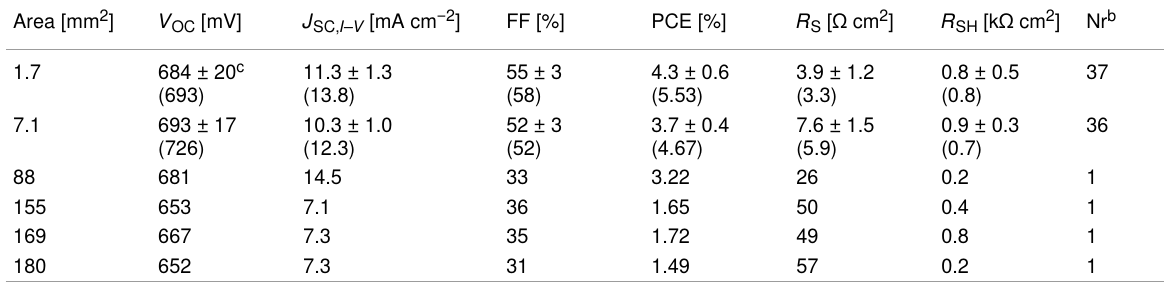
Table 2: Photoconversion parameters a of solar cells as a function of active area. The best results are given in parentheses. Area [mm 2